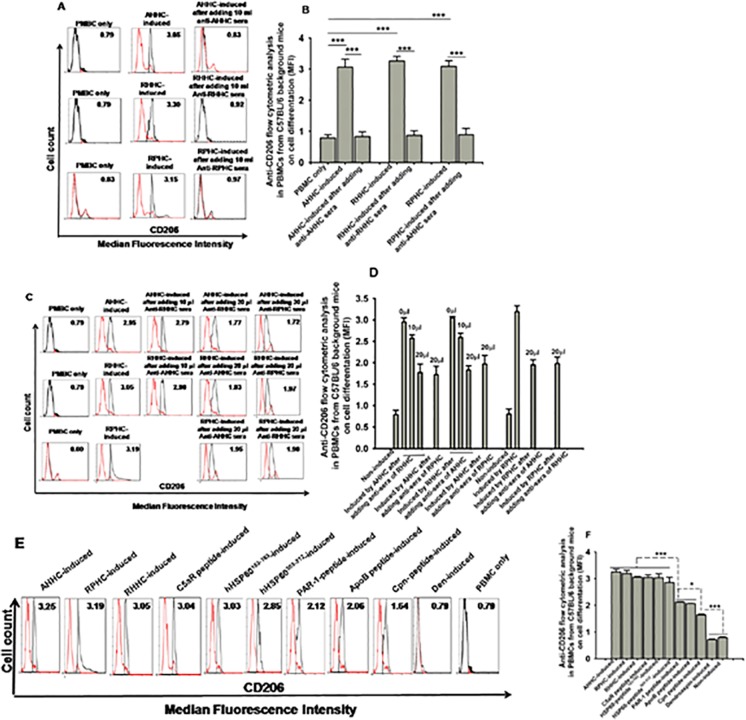
Evaluation of monocyte differentiation into macrophages.(A and B) PBMCs differentiation stimulated by recombinant constructs (1 μg/ml) as assessed by analyses of CD206 expression by flow cytometry and inhibition of differentiation in the presence of respective construct-induced antibodies. (C and D) Inhibition of differentiation by respective and other construct induced antibodies. (E and F) Individual peptide as a stimulator (1 μg/ml) of monocyte differentiation as analysed by CD206 expression. Data are expressed as average values of 3 analyses.